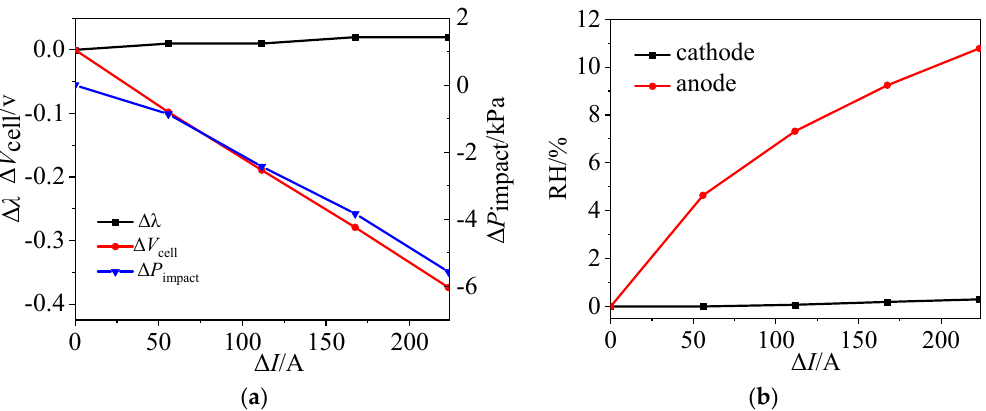
Figure 10. Changes in PEMFC state with current changes. ( a ) pressure impact, membrane water and output voltage ( b ) RH.